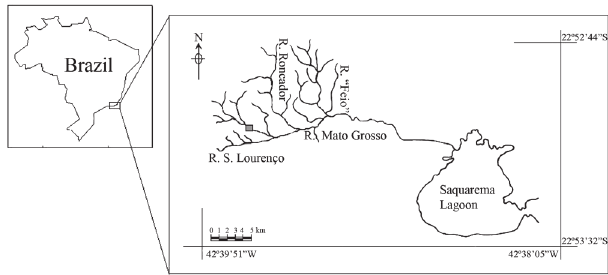
Fig. 1. Mato Grosso fluvial system with indication of the sample site (grey